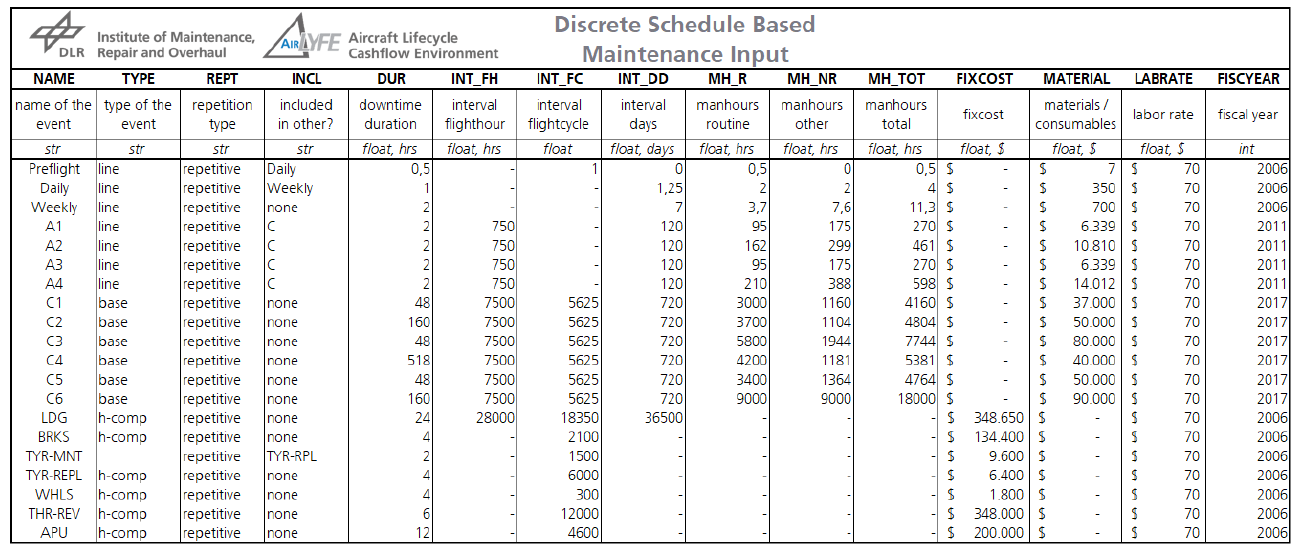
Figure A2. Excerpt of LYFE’s Excel-based input mask for discrete scheduled